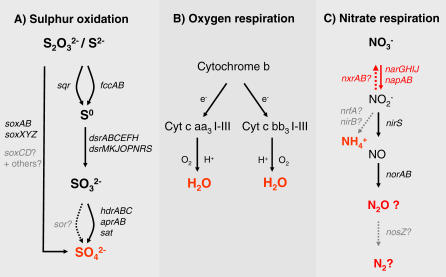
Predicted Sulfur, Oxygen, and Nitrogen Metabolism of Beggiatoa Sp.(A) Overview of the encoded genes catalyzing sulfur species oxidation. A sulfite acceptor oxidoreductase was not indicated, in contrast to earlier experimental evidence in non-vacuolated Beggiatoa [47]. Note that thiosulfate is probably oxidized via the Sox pathway.(B) Final steps in oxygen respiration. The depicted cytochrome c oxidases show different affinities to oxygen: the cbb3 type has a higher affinity than the aa3 type.(C) Nitrate respiration. Enzymes reducing nitrite to ammonia and nitrous oxide to dinitrogen, respectively, were not found.